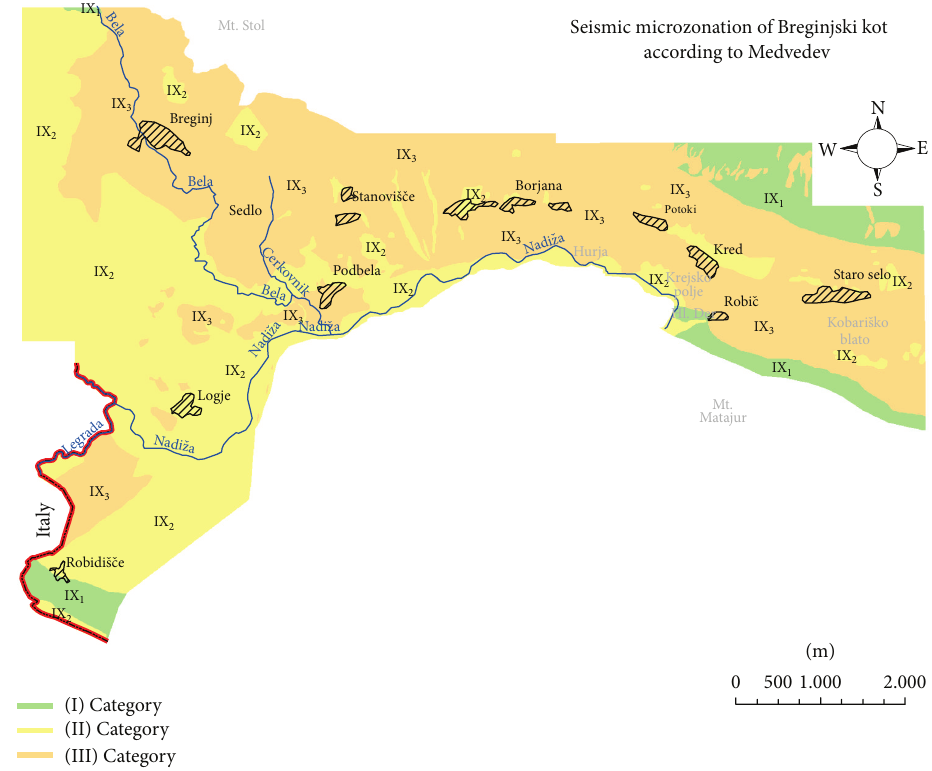
Figure 5: Intensity increments seismic microzonation of Breginjski kot according to the Medvedev method.